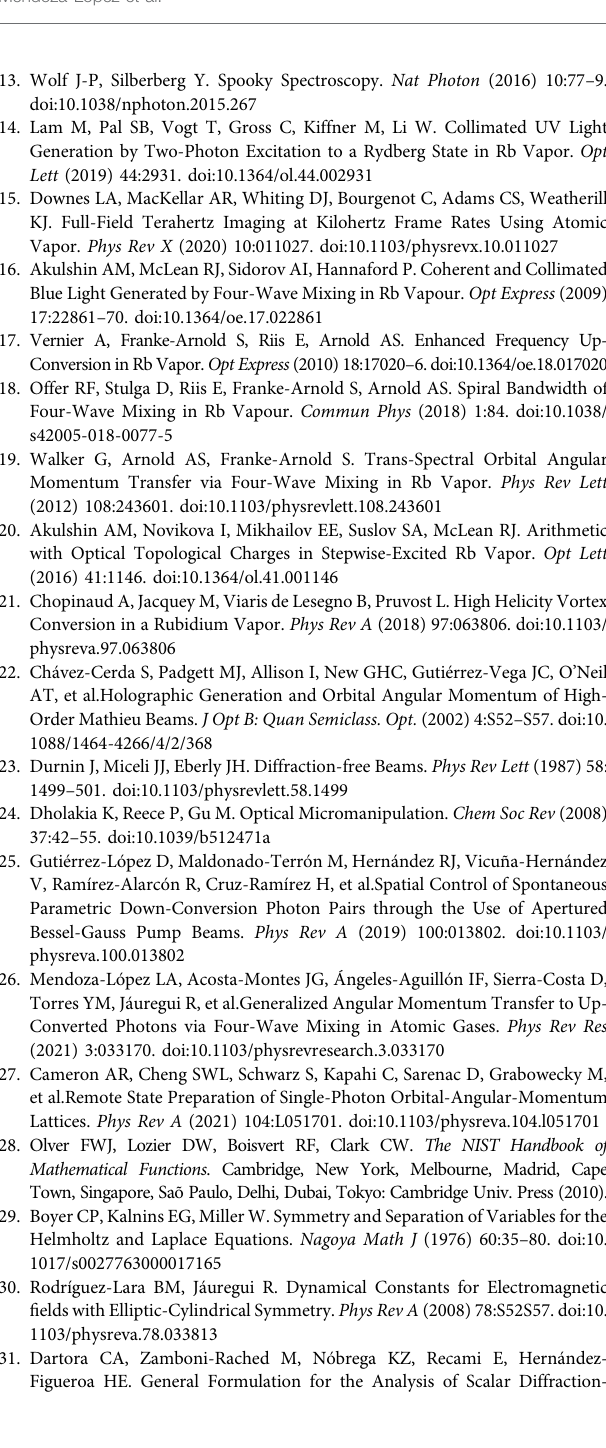
Figueroa HE. General Formulation for the Analysis of Scalar